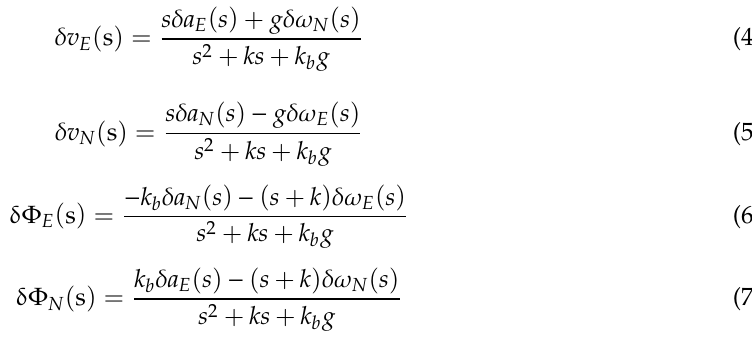
Figure 4. Error model of the self-alignment loop. While E(N)-axis velocity error (cid:2012)(cid:1874) (cid:3006) ((cid:2012)(cid:1874) (cid:3015) ) induces N(E)-axis attitude error δΦ (cid:3015) ( δΦ (cid:3006) ), vertical attitude is not related to horizontal velocity errors.